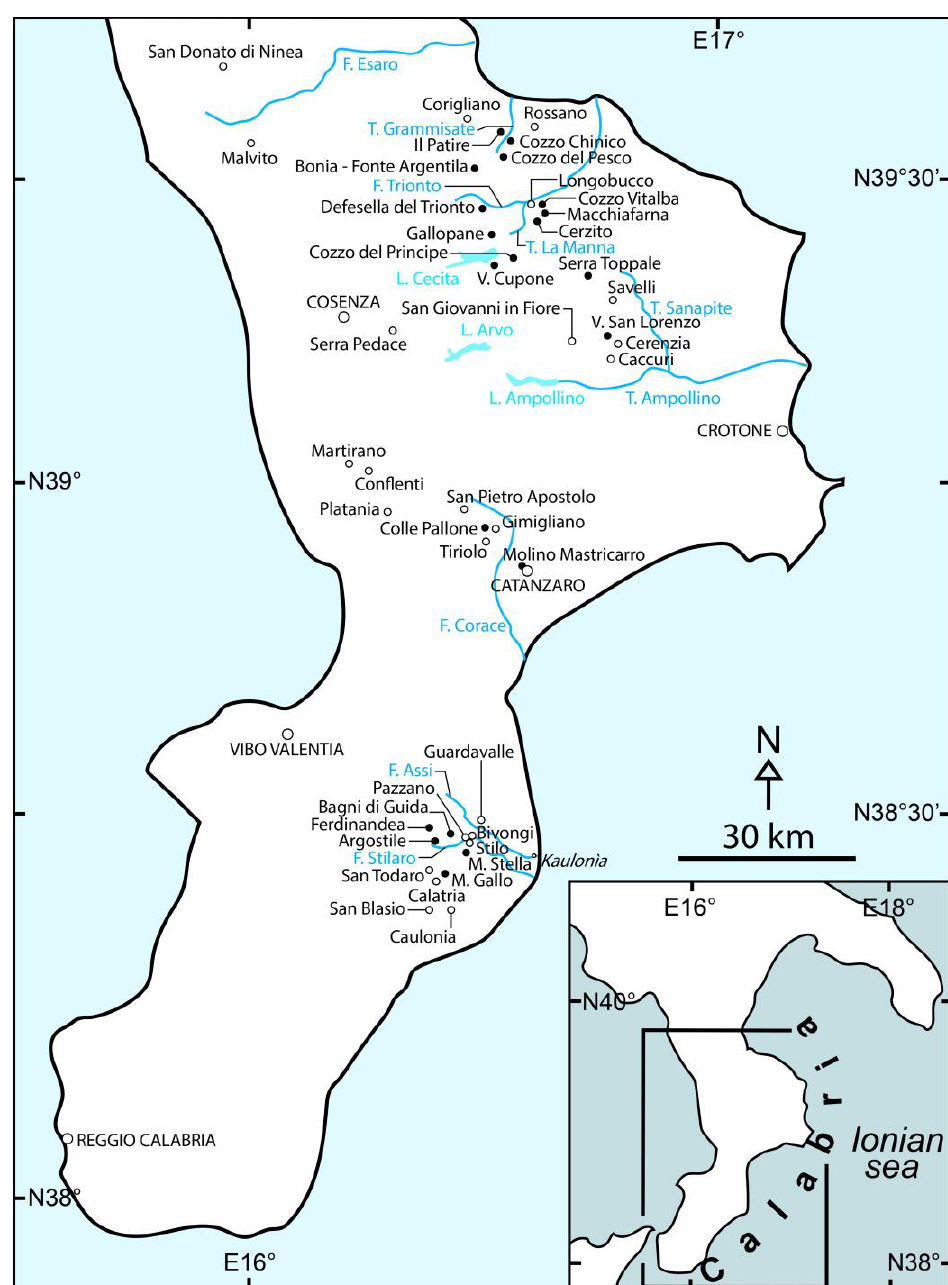
Figure 1. Geographic sketch-map of Calabria with toponyms of the areas characterized by mineral- ization.